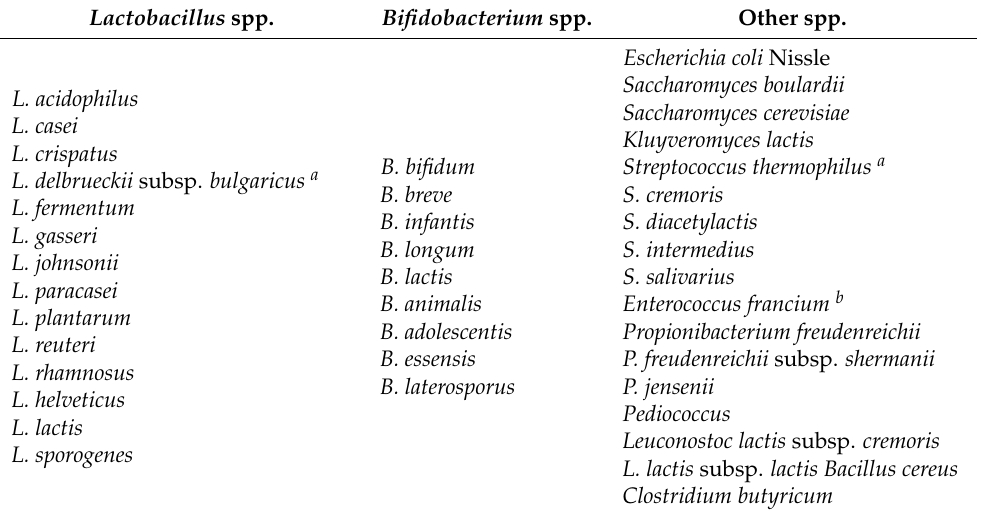
Table 1. Microorganisms used as probiotic cultures.